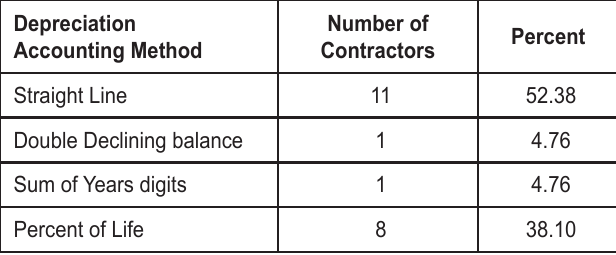
Table 4: Depreciation accounting method